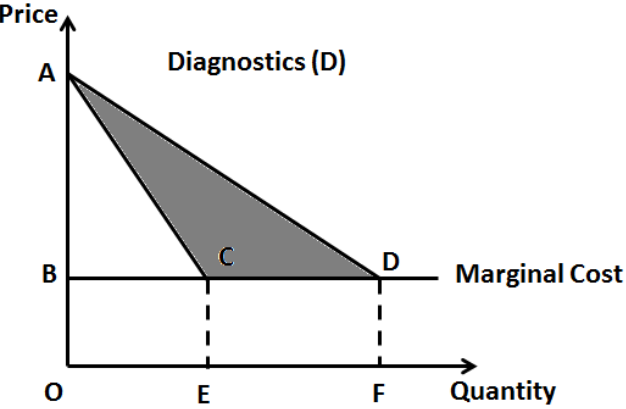
Figure 1. Impact of personalized medicine on total revenues of already existing pharmaceutical treatment entities. M PM refers to the marginal cost following adoption of precision therapy and M ET refers to the marginal cost of the current empirical therapy. ∆ ABD-total revenue of already existing entity from personalized medicine; A sum of ‘ADE’ and ‘BCFE’ would be the total loss (or lost revenues) from personalized medicine.